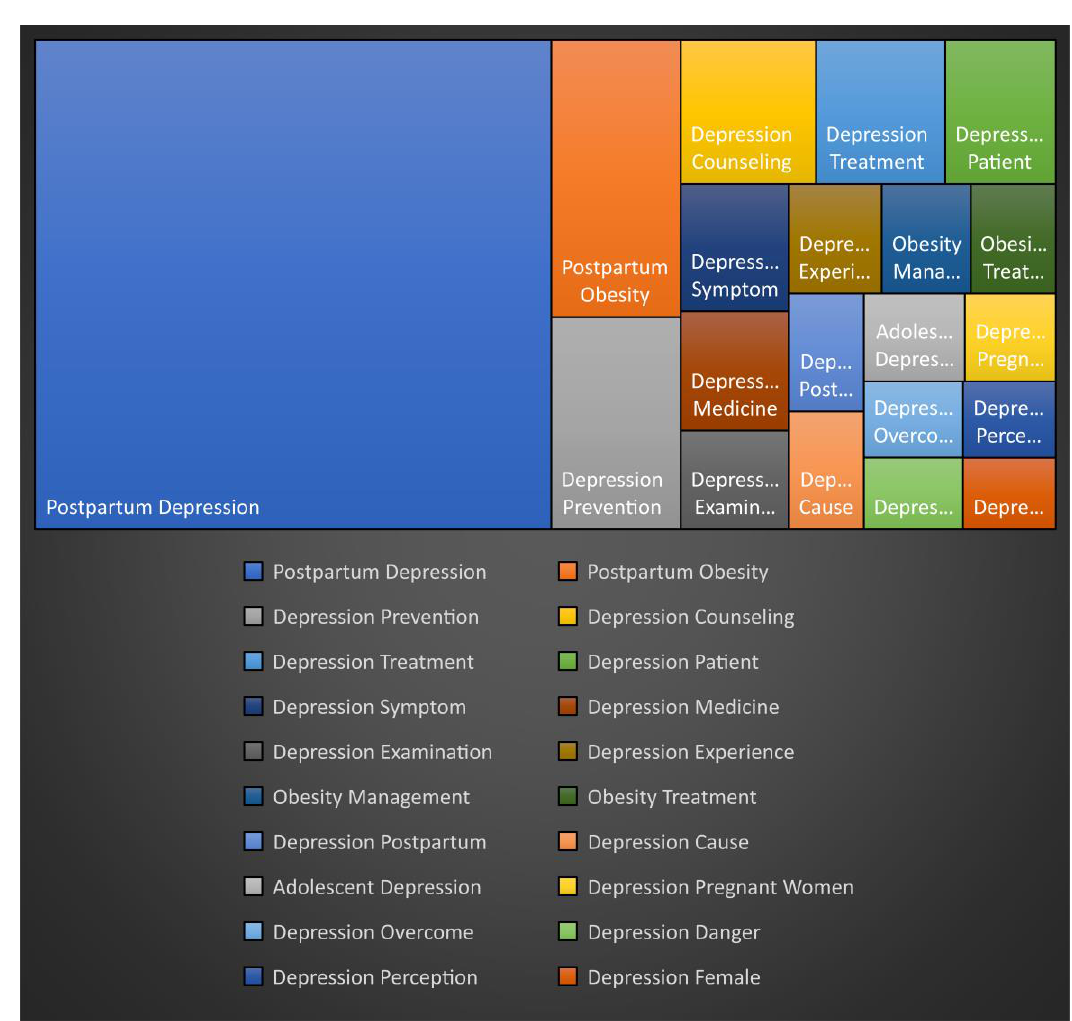
Figure 1. Frequency of keywords by N-gram analysis.